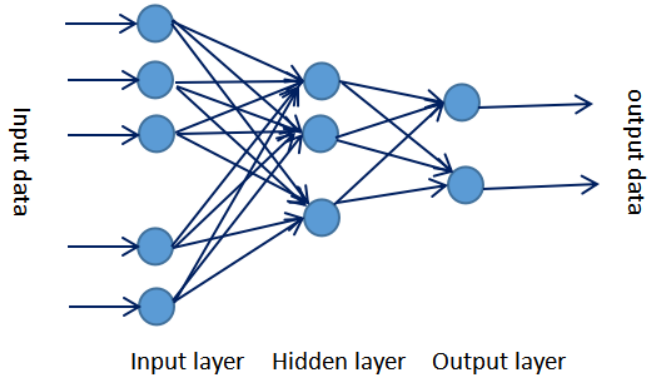
Figure 4. Deep learning neural network model.